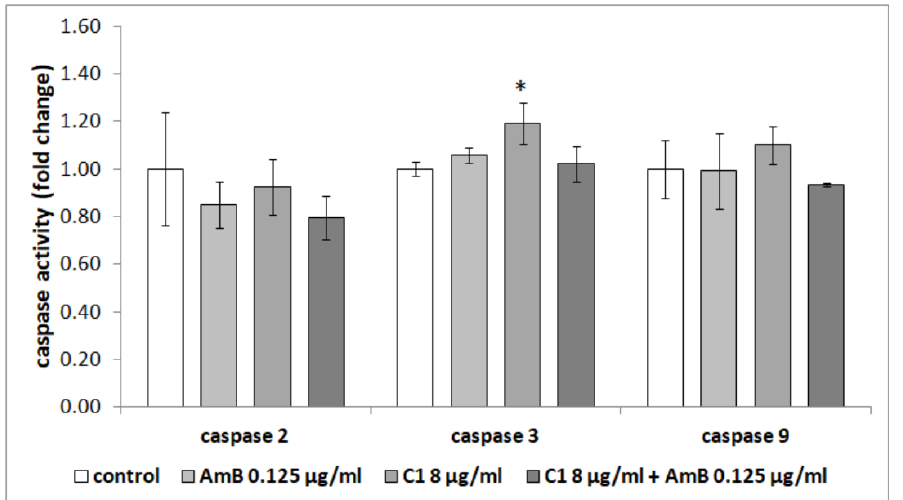
Figure 6. Effect of the combination of AmB with thiadiazole C1 on the activity of caspases in the RPTEC cells. The results are presented as fold changes relative to the control cells and are reported as the mean ± SD, statistical significance: * p < 0.05 (Tukey post hoc test).